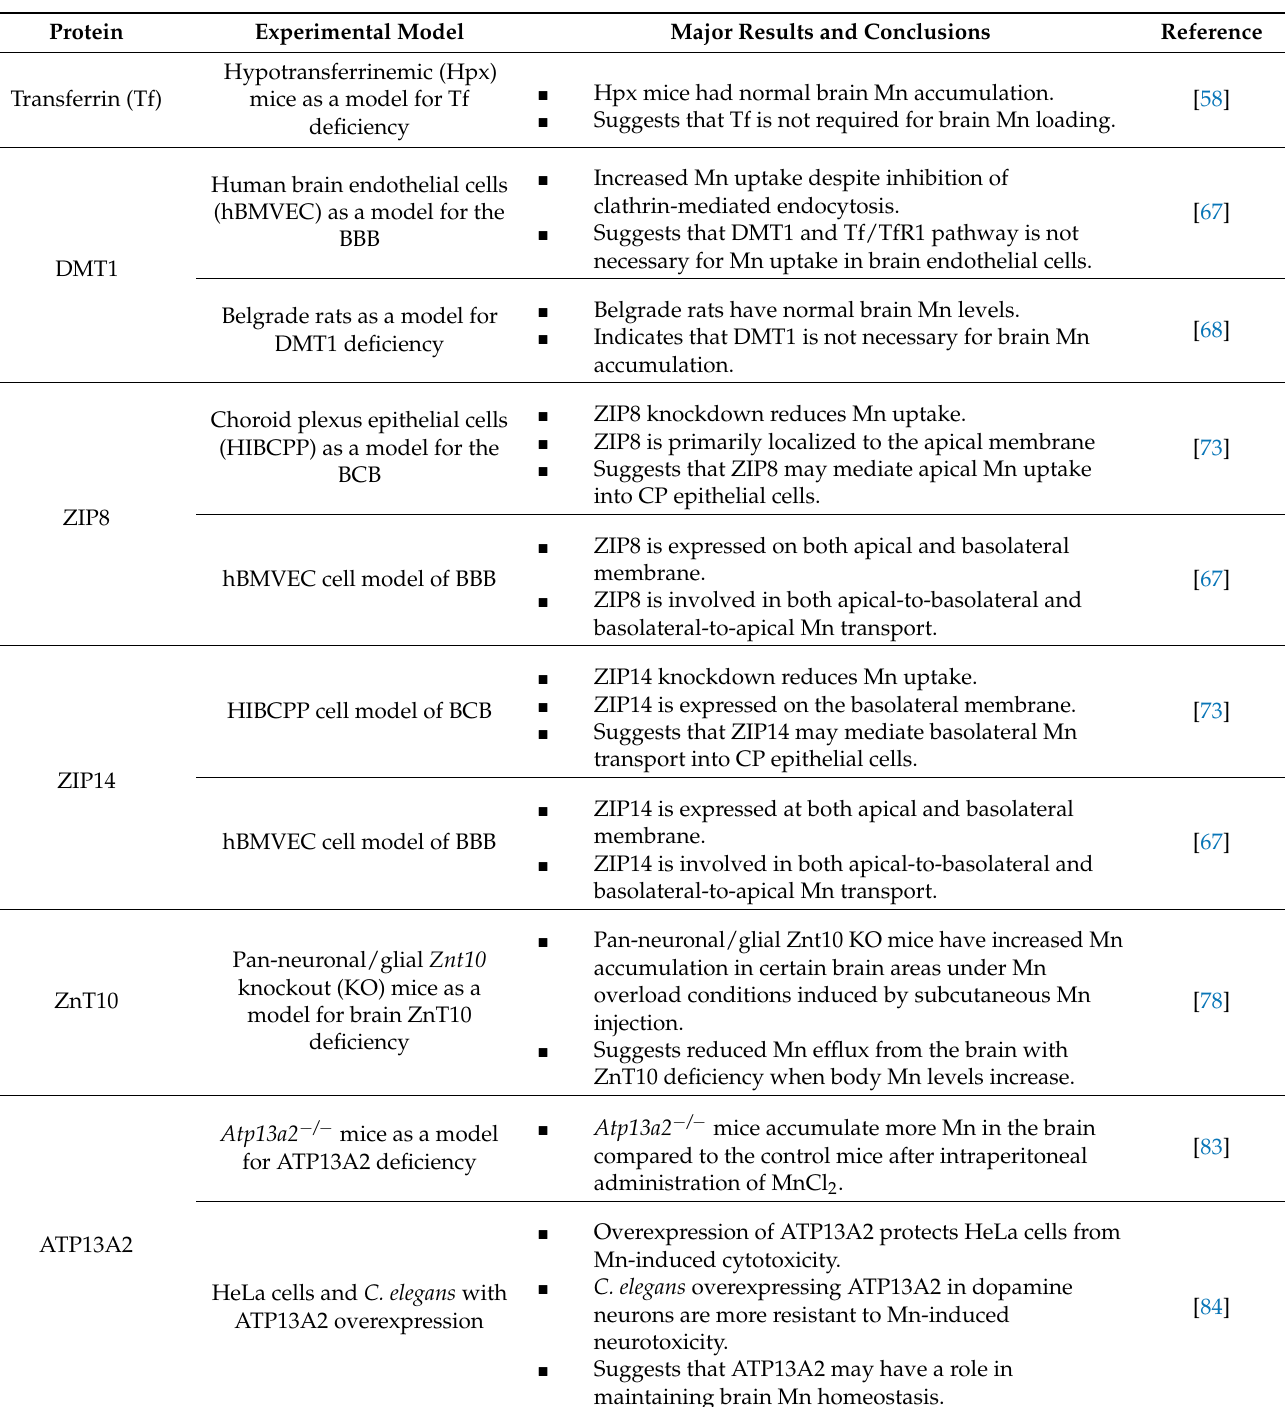
Table 1. Evidence of metal transporters involved in Mn homeostasis at the brain barriers. Protein Experimental Model Major Results and Conclusions